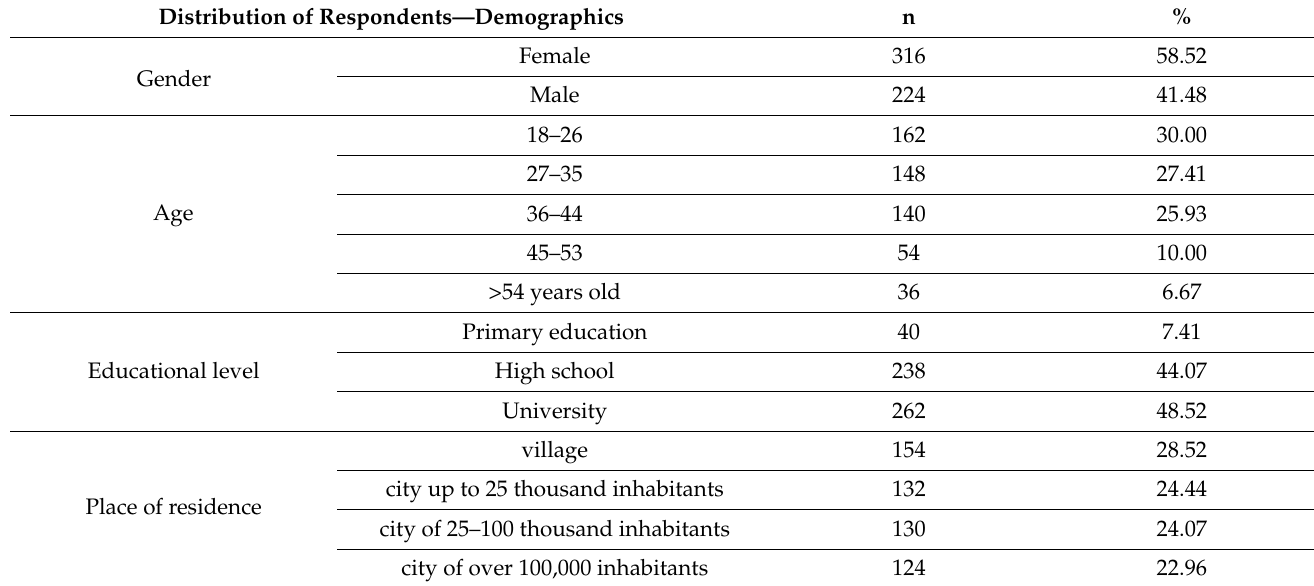
Table 2. Detailed characteristics of the